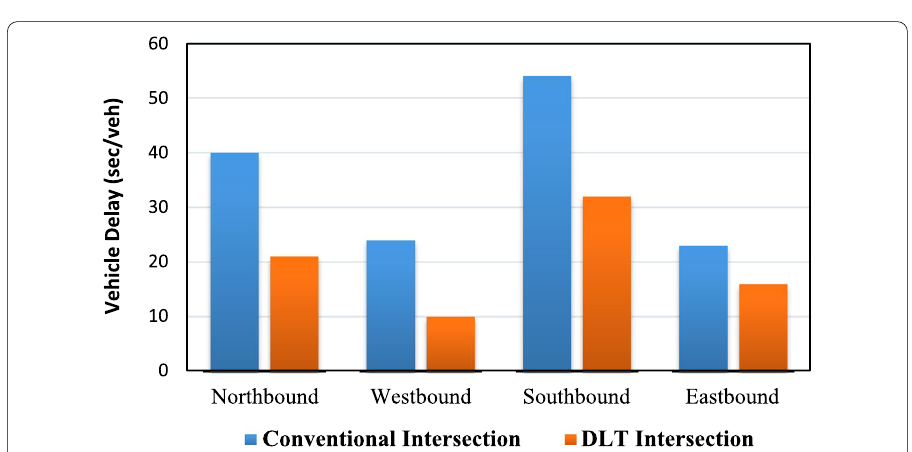
Fig. 11 Visual simulated traffic for DLT